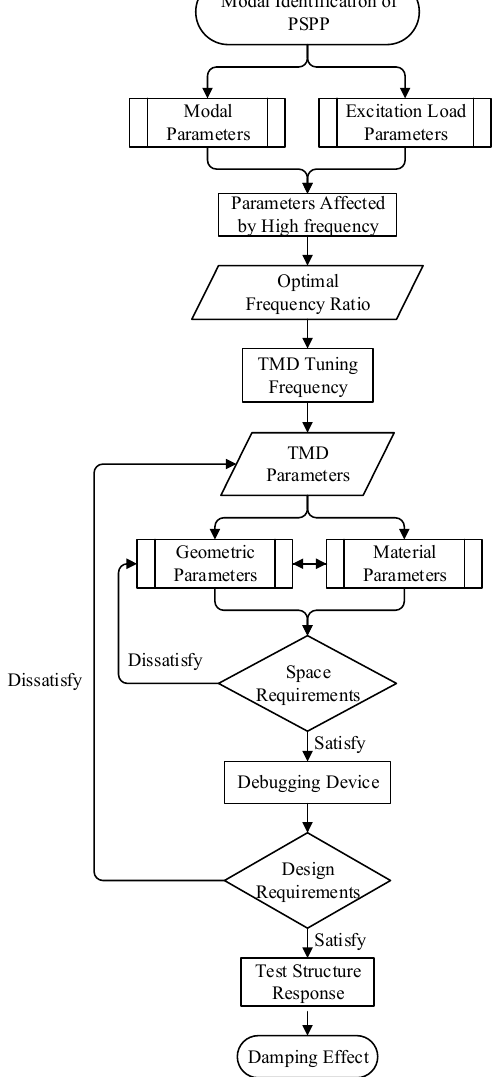
Figure 2. High-frequency TMD vibration control method for structures of a pumped storage power plant